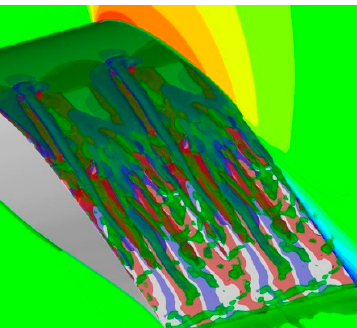
Figure 30. Isosurfaces of Q = 10, streamwise vorticity, ω x = − 10, 10, and isocontours of velocity magnitude computed from time-average for pulsed VGJs with B = 4. (Reprinted from [31]).